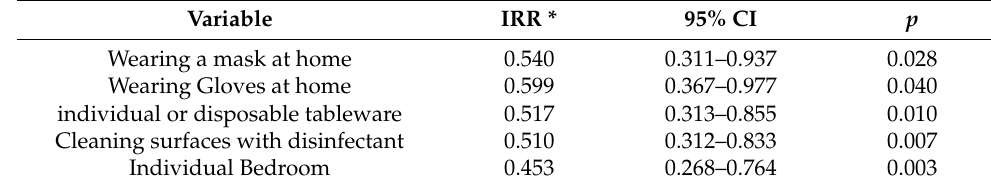
Table 5. Multivariate Exact Poisson regressions of secondary transmission according to preventive measures taken by health workers to prevent infection at